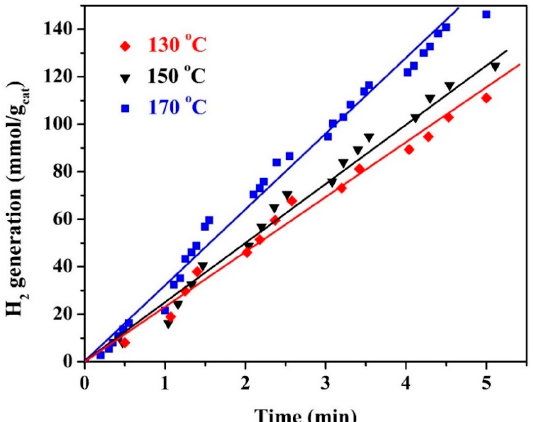
Figure 13. Influence of the hydrothermal treatment temperature on the hydrogen production rate from water splitting under visible light radiation; KOH concentration of 1.0 M, hydrothermal time of 3 h, and calcination temperature of 800 °C.